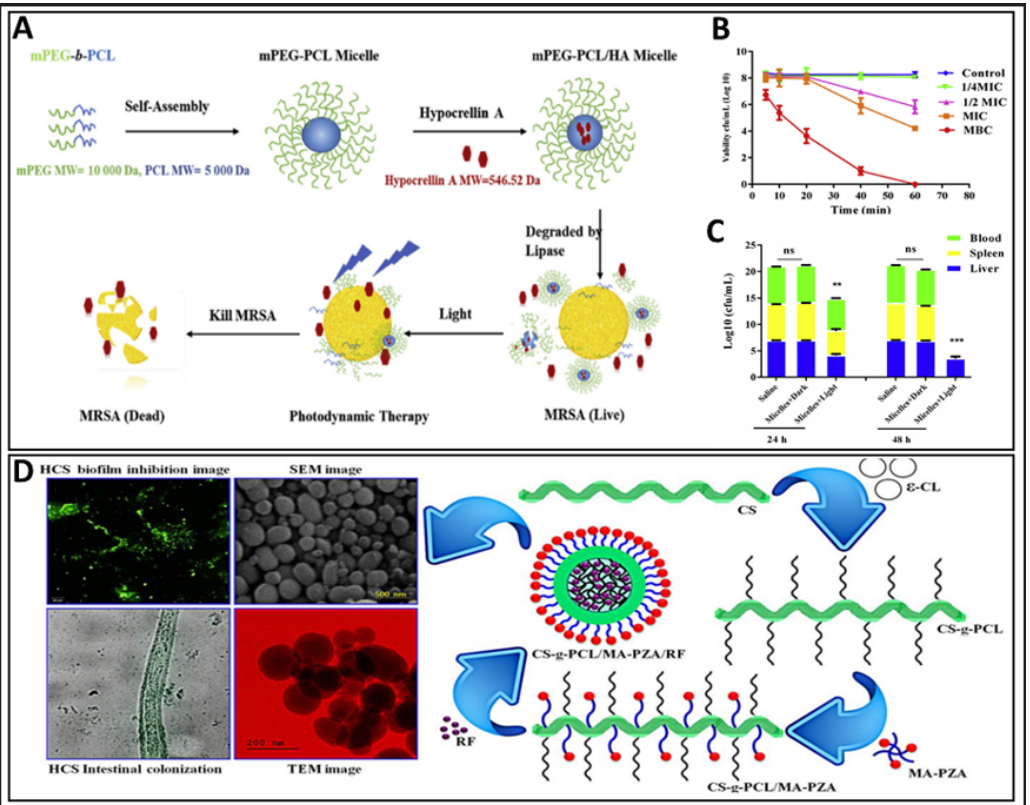
Figure 6. ( A ) Preparation of (mPEG-b-PCL) HA micelle for photodynamic antibacterial activity. ( B ) Antibacterial activity of micelles at different irradiation times. ( C ) Total bacterial count in blood, spleen and liver after dark and light irradiation with micelles for 24 and 48 h. Reprinted with permission from [22] © Elsevier 2019. ** p < 0.01, *** p < 0.001. ( D ) Schematic representation of fabrication, characterization and evaluation of CS-g-PCL/MA–PZA micelles. Reprinted with permission from [84] © Elsevier 2020. More PMs were studied for MRSA infections. In such a study, chitosan-grafted polycaprolactone/maleic anhydride-pyrazinamide (CS-g-PCL/MA–PZA) polymer was used for the dual delivery of rifampicin (RF) and pyrazinamide (PZA). The synthesis of the polymer involved the steps of preparing chitosan-grafted polycaprolactone and maleic anhydride-pyrazinamide separately and then finally the combination of both these structures. The dialysis method was used for the preparation of rifampicin-loaded micelles. A prolonged drug release was observed from the micelles. After 12 days, 76.54% and 83.25% of rifampicin and pyrazinamide, respectively, were released from the micelles. The antibacterial effect of the formulation was promising for the drug delivery of MRSA drugs such as rifampicin and pyrazinamide (Figure 6D) [84]. When chlorophyll was delivered in the form of micelles formed from poloxamer, a significant photosensitization effect was used. This was observed as the photodynamic inactivation of Staphylococcus aureus . Photodynamic therapy is dependent on the micelle system by enhancing the uptake of chlorophyll by the bacterial cells [85].